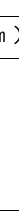
Table 2. Median radius for mono-modal log-normal size distribu- tions shown in Fig. 2 and corresponding effective radius and scat- tering radius at 826cm − 1 . The width is set to